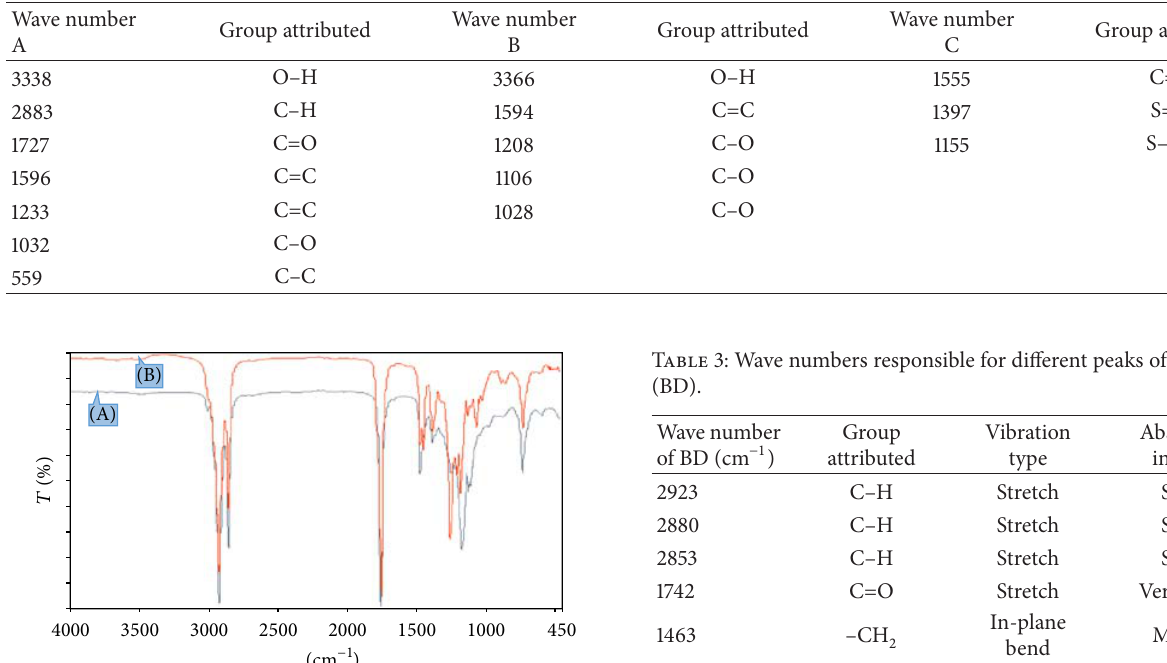
Table 2: Wave numbers of FTIR spectra and associated bonds for untreated saw dust (A), carbonized saw dust (B), and carbonized + sulphonated saw dust (C).